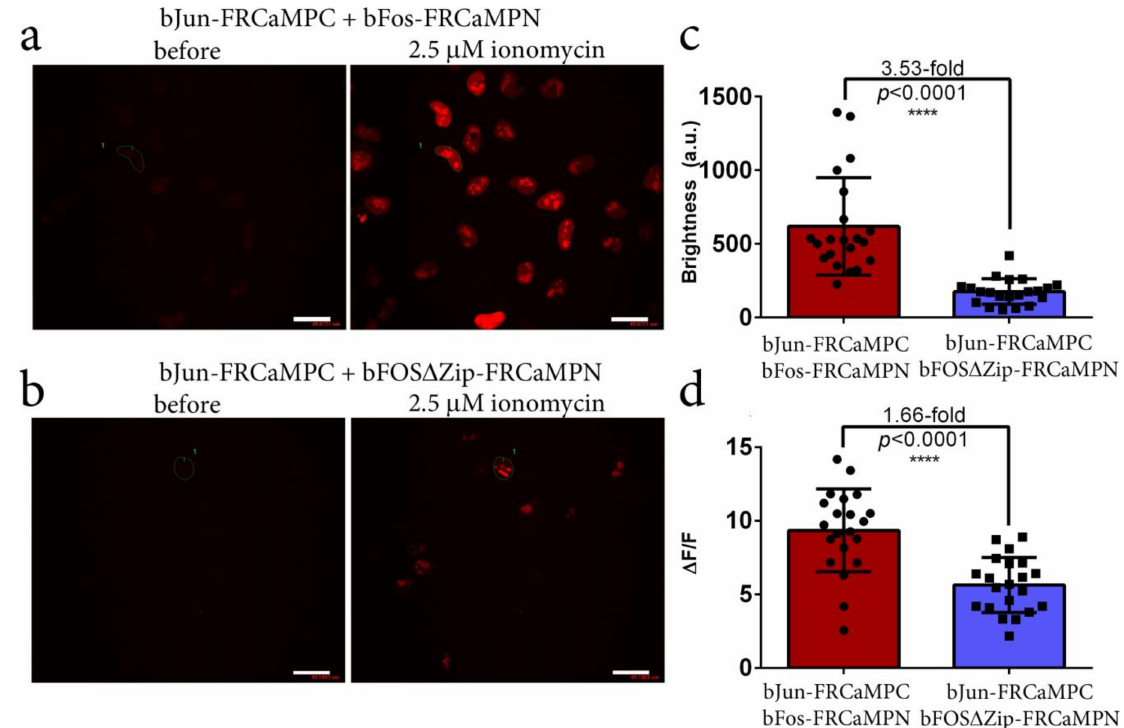
Figure 7. Localization, brightness, and responses of the split-version of the FRCaMP indicator to Ca 2+ variations in HeLa cells depending on the presence of the heterodimerizing (bJun-FRCaMPC/bFos-FRCaMPN) or non-heterodimerizing (bJun-FRCaMPC/bFOS ∆ Zip-FRCaMPN) pair. ( a ) Confocal images of HeLa cells co-expressing the heterodimerizing bJun- FRCaMPC and bFos-FRCaMPN split calcium indicator before and after the addition of 2.5 µ M ionomycin. ( b ) Confocal images of HeLa cells co-expressing the control non-heterodimerizing bJun-FRCaMPC and bFOS ∆ Zip-FRCaMPN split calcium indicator before and after the addition of 2.5 µ M ionomycin. ( a , b ) Red fluorescence channel corresponding to excitation and emission at 561 and 617/73 nm, respectively. Scale bar, 50 µ m. For the selected cells (marked with label 1), zoomed images and time-lapses are shown in Figure S6. The brightness levels are the same for both panels in the comparison. ( c , d ) Comparison of the average brightness ( c ) and ∆ F/F responses ( d ) for the heterodimerizing bJun-FRCaMPC and bFos- FRCaMPN split calcium indicator and their control non-heterodimerizing bJun-FRCaMPC and bFOS ∆ Zip-FRCaMPN split calcium indicator in HeLa cells upon the addition of 2.5 µ M ionomycin. Comparison of the averaged brightness before ionomycin addition at low calcium ions concentrations is shown in Figure S7. Error bars represent the standard deviations across twenty-one cells (three cultures); p -values show statistical differences between the respective values. ****, the p -value is lower than 0.0001. We used 1600 ng concentration of the plasmids for the transfection in 24-well